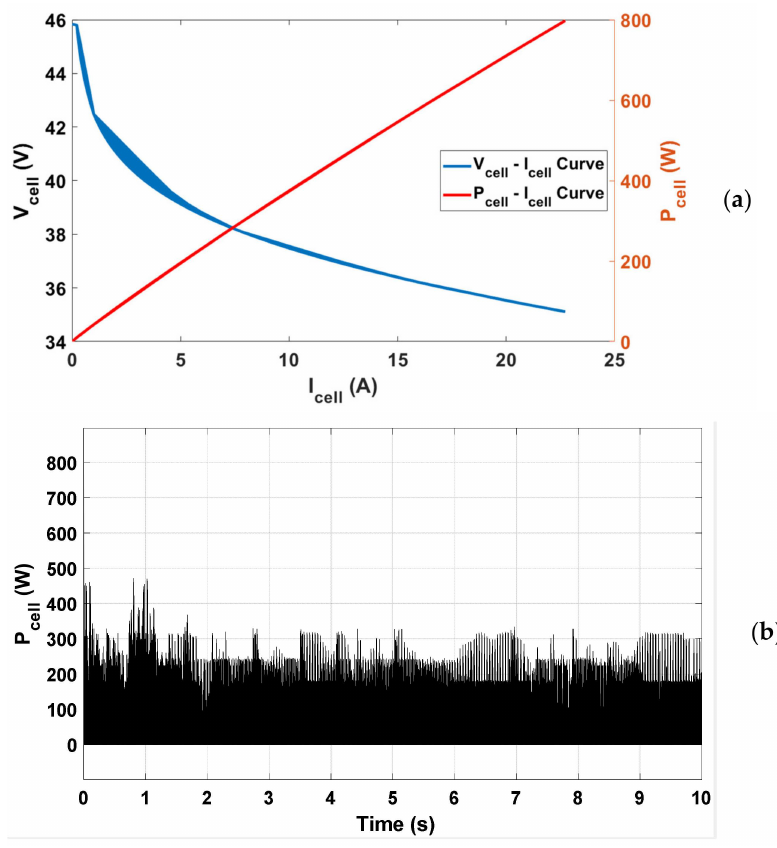
Figure 12. ( a ) The curves of V cell − I cell and P cell − I cell during the spiral route tracking of AGV. ( b ) The variation of the consumed power during the spiral route tracking of